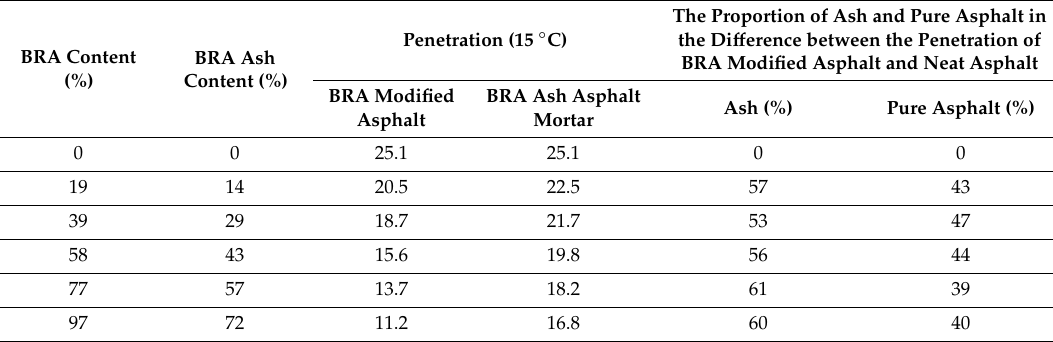
Table 8. Percentage of penetration of di ff erent components in